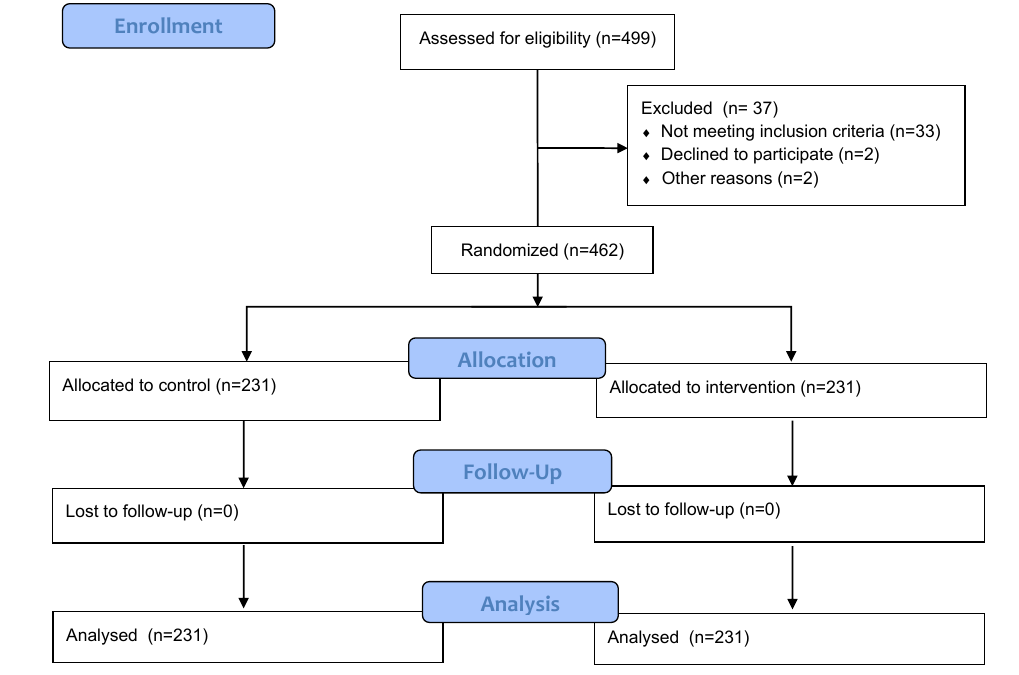
Figure 1. CONSORT Flow diagram of the